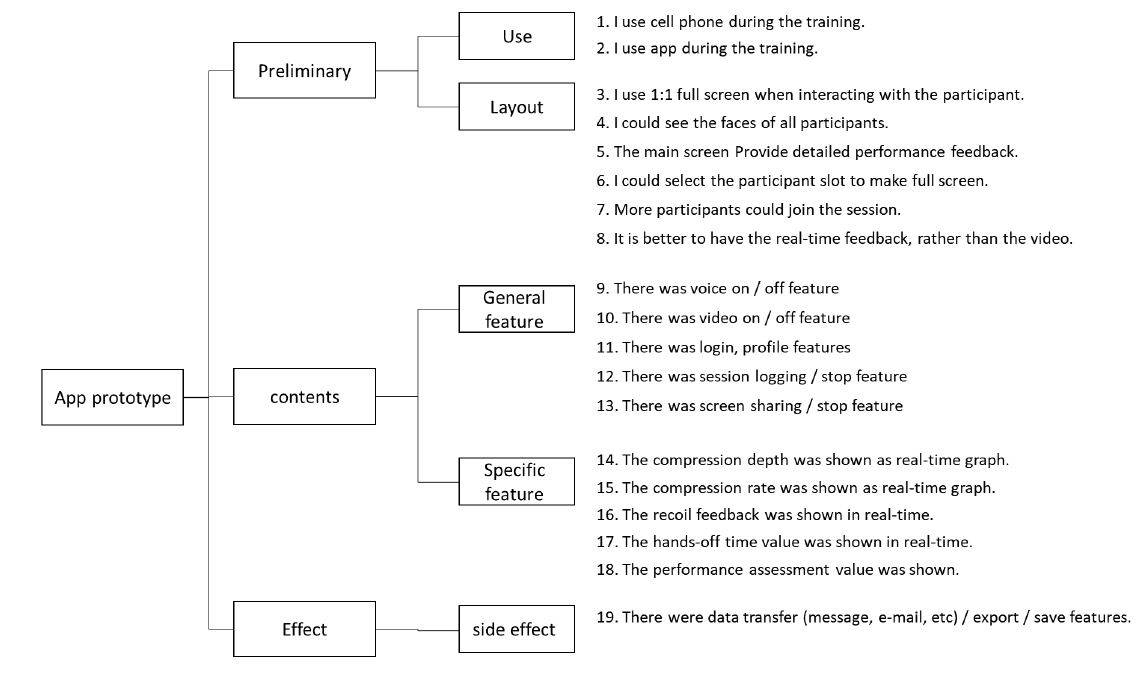
Figure 1. Classification of proto-application function.